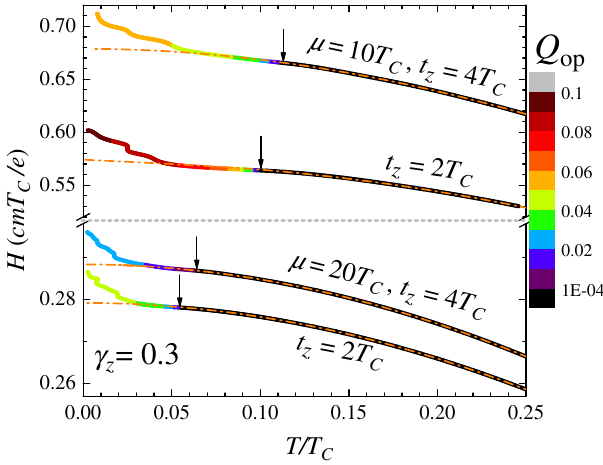
FIG. 3. Examples of the temperature dependences of the upper 0 . 3 , two Fermi critical field for the spin-splitting factor γ z ¼ energies μ ¼ 10 T (upper part) and 20 T (lower part), and two C C 2 T hopping energies t and 4 T . The boundaries are color z ¼ C C coded by the optimal modulation wave vector Q . The arrows op mark the location of the FFLO transition temperature T . The FFLO orange dash-dot lines show quasiclassical results.